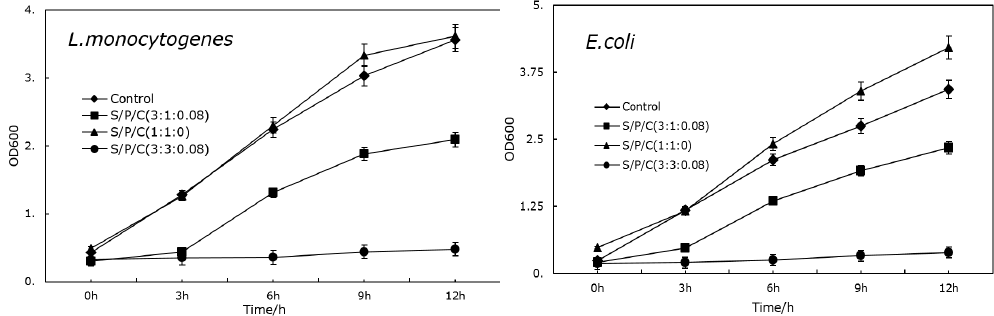
Figure 5. Antimicrobial activity of degradable antibacterial film against foodborne pathogenic bacteria, L. monocytogenes and E. coli .